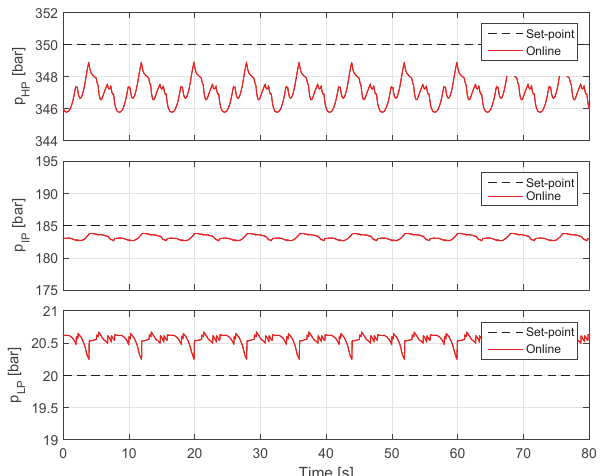
Figure 15: Pressure levels of the three pressure lines with the online pressure reference shaping method.